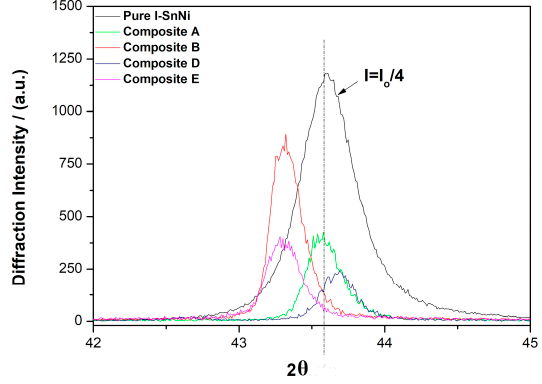
Figure 10. Representative XRD patterns of pure and composite deposits focused at 2 θ ≈ 43.6°.